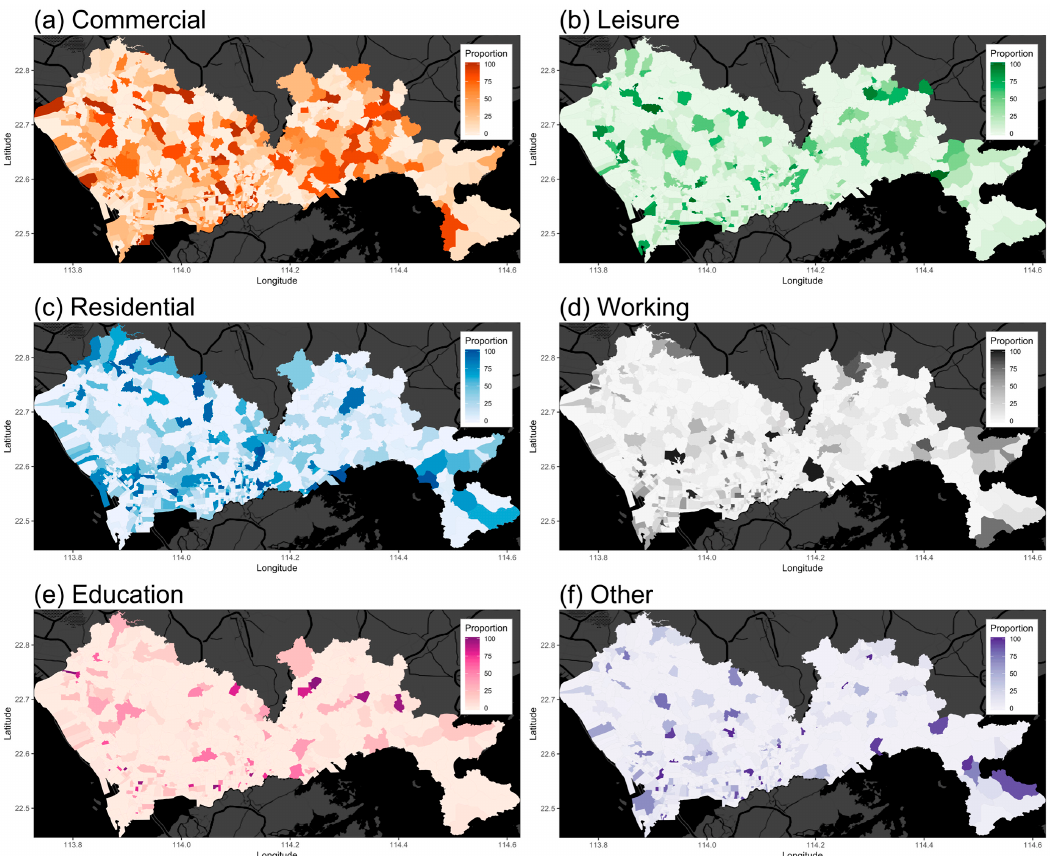
Table 1. Reclassified point of interest (POI) categories.